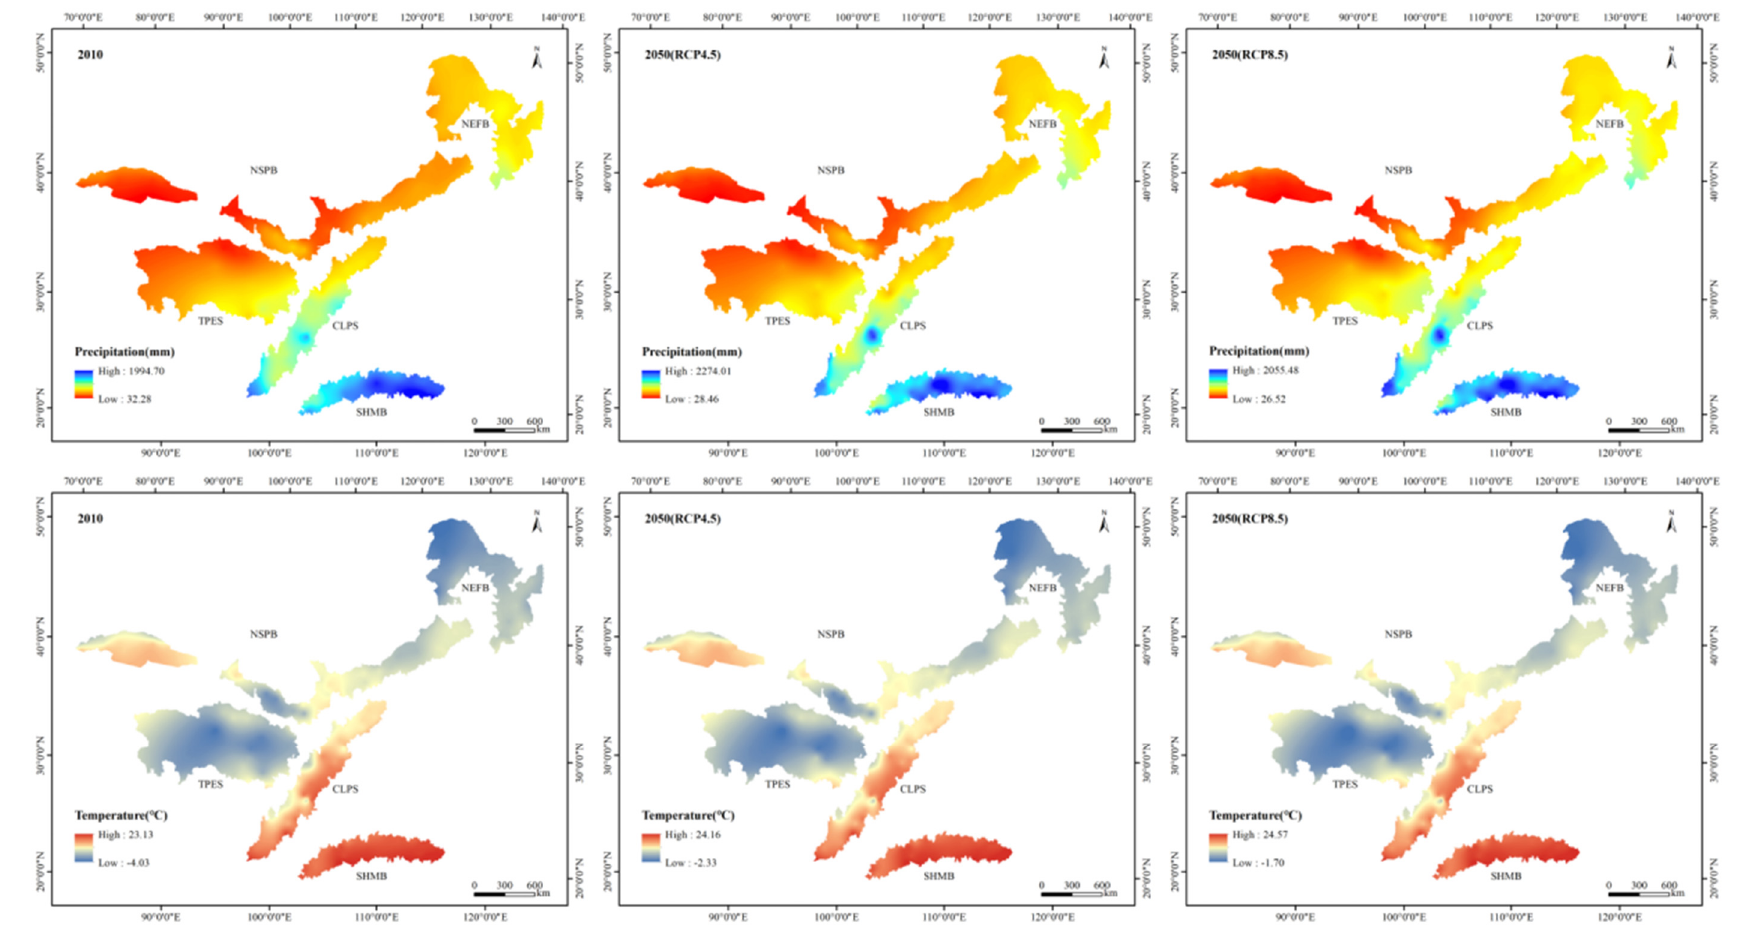
Figure 4. Spatial distribution of precipitation and temperature in 2010 and under Representative Concentration Pathway (RCP)4.5 and RCP8.5 scenarios in 2050.